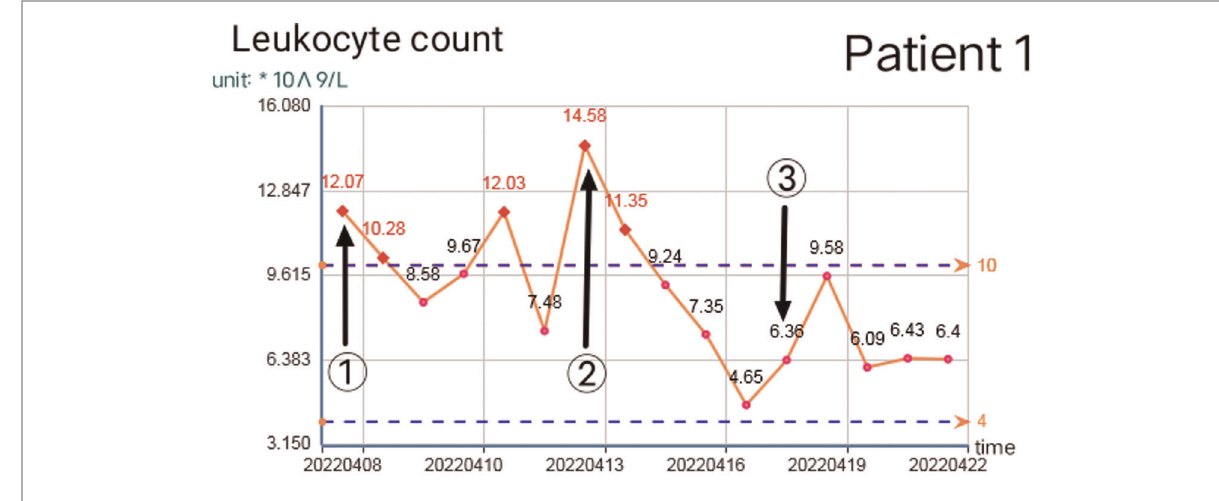
FIGURE 8 Change of leukocyte count in patient 1 ( ① , ② , and ③ are the debridement time of the fi rst, second, and third operations respectively).